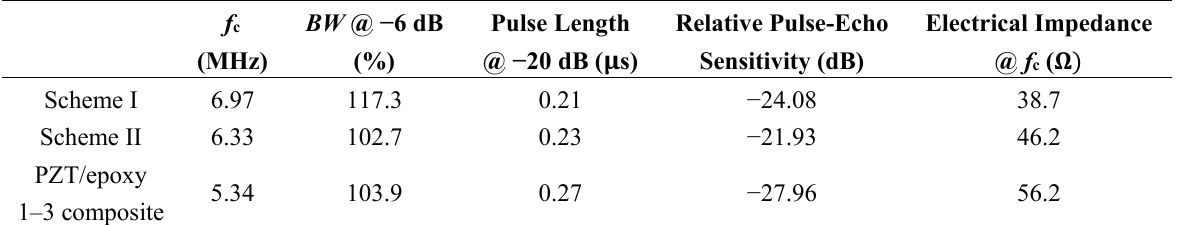
Table 4. The actual parameters of the TOFD ultrasonic